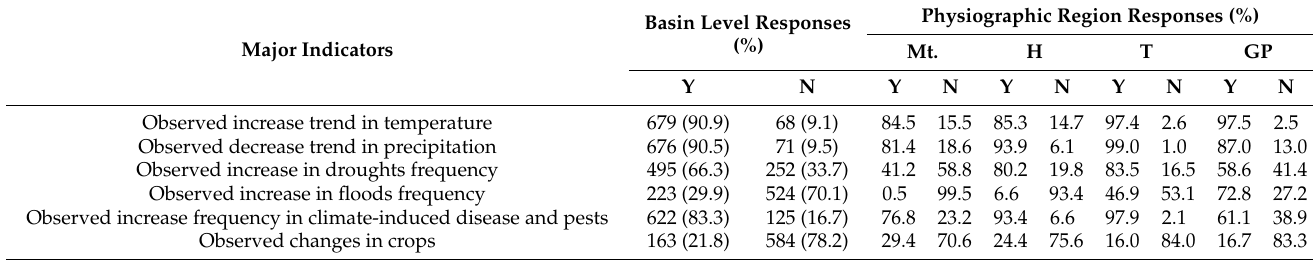
Note: Total values were calculated based on 747 household surveys (HSs). Mt. refers to mountain region, H is for hill, T for Tarai, and GP for Gangetic plain. Furthermore, Y refers for Yes and N for No. Values by physiographic region were calculated based on 194 HSs for the mountain and Tarai regions, 197 HSs for the hill region, and 162 HSs for the Gangetic plain regions of the KRB. Sources: Field Surveys 2018 and